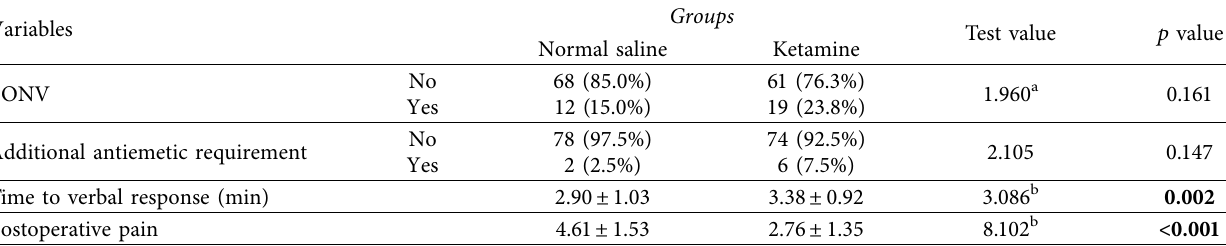
Table 5: Postoperative follow-up